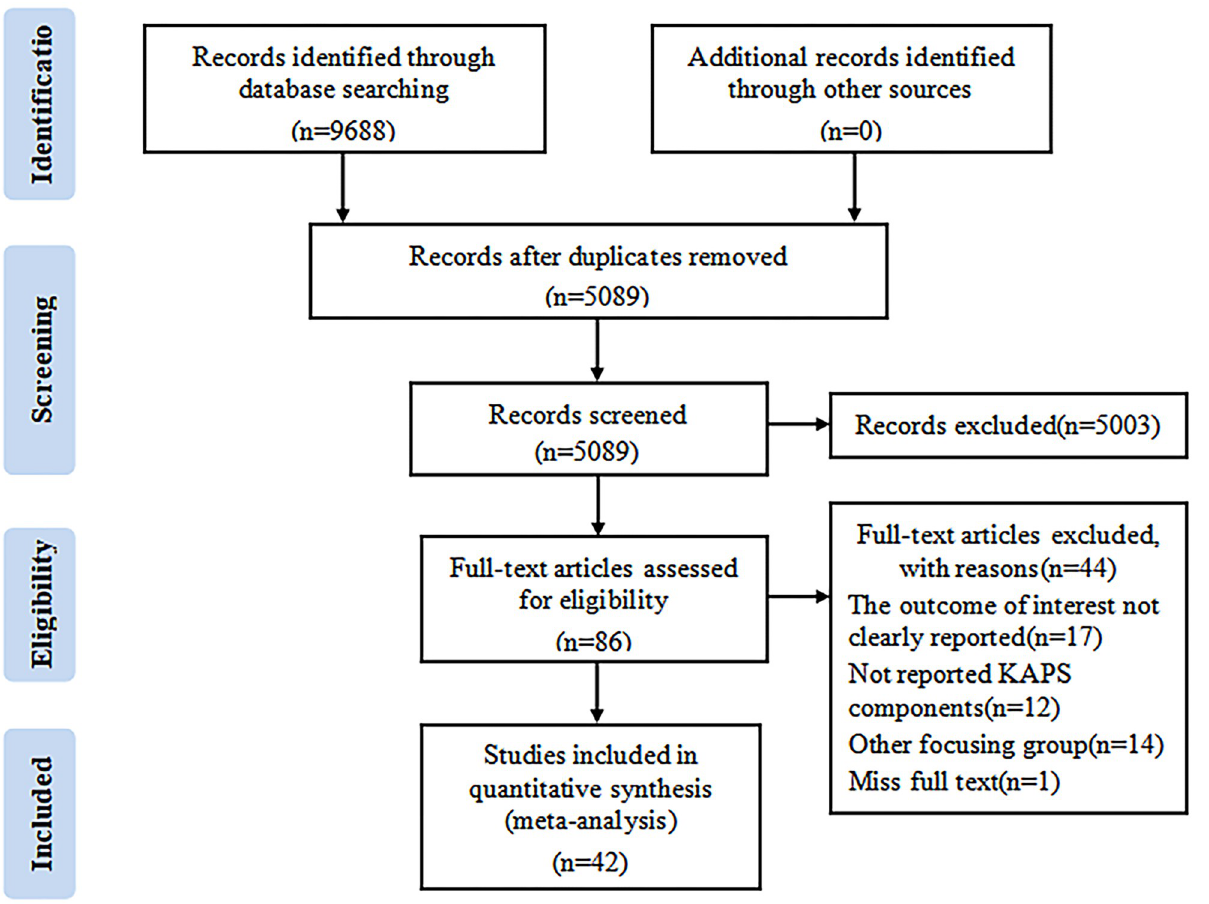
Fig 1. PRISMA 2009 flow